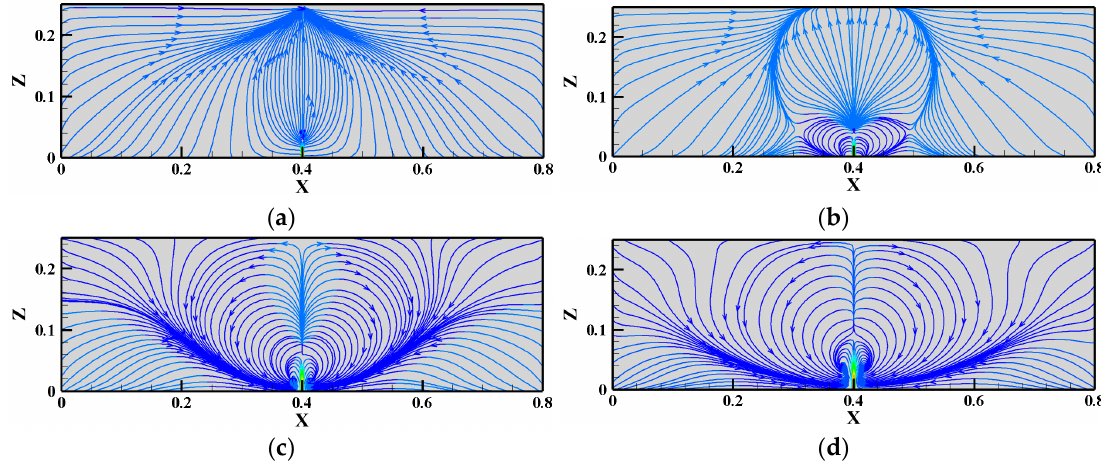
Figure 9. Vortex of the circular jet at cross-section Y = 0: ( a ) case 1, ( b ) case 2, ( c ) case 3, ( d ) case 4.